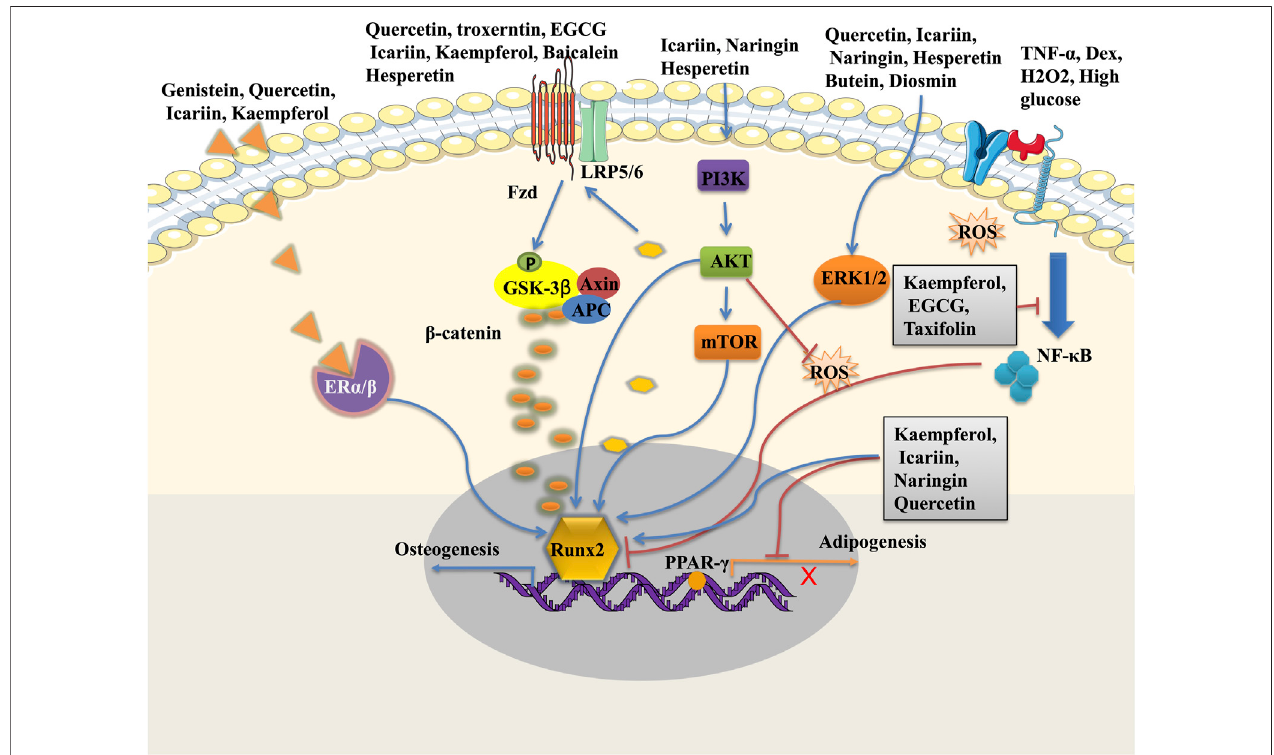
FIGURE 2 | Signalling pathways of fl avonoids in MSCs osteogenic